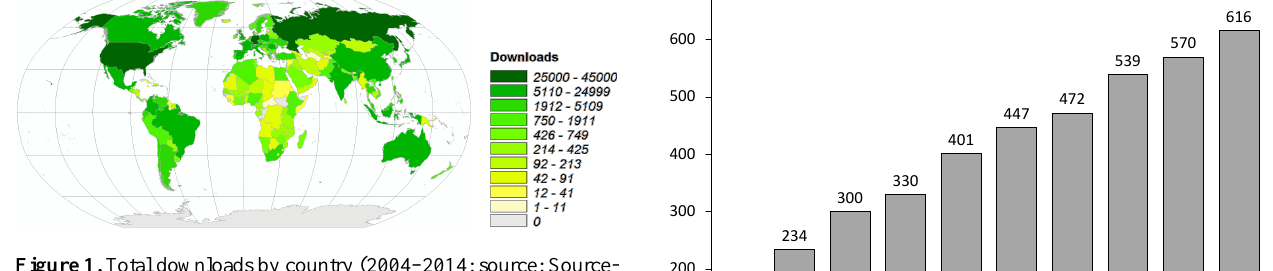
Figure 1. Total downloads by country (2004–2014; source: Source- Forge.net, 2014).